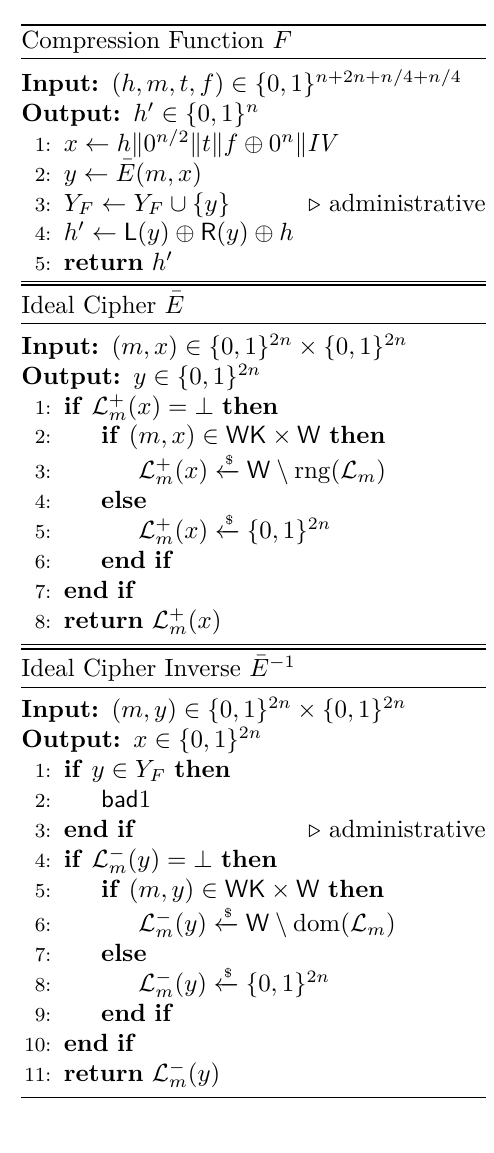
Figure 3: Real world ( F, ¯ E ) (left) and simulated world ( R , S ) (right). The statements “administrative” do not influence the operation of the oracles and are purely included for administrative reasons. The description of S is identical to that of Figure 2, S − 1 differs only in the addition of lines